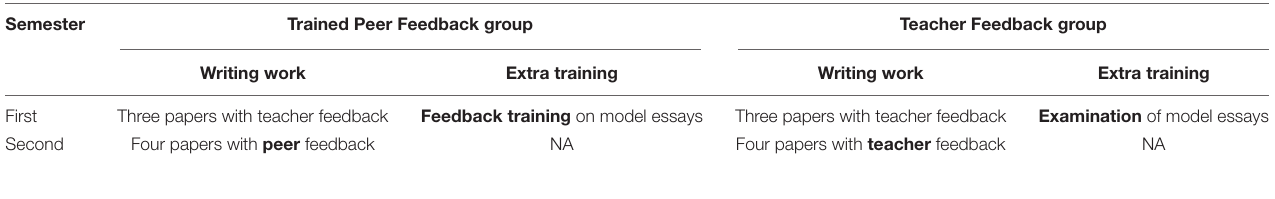
TABLE 1 | Overview of writing and training across conditions: training in the first semester, contrast of peer vs. teacher feedback in the second semester (key condition differences in bold). Semester Trained Peer Feedback